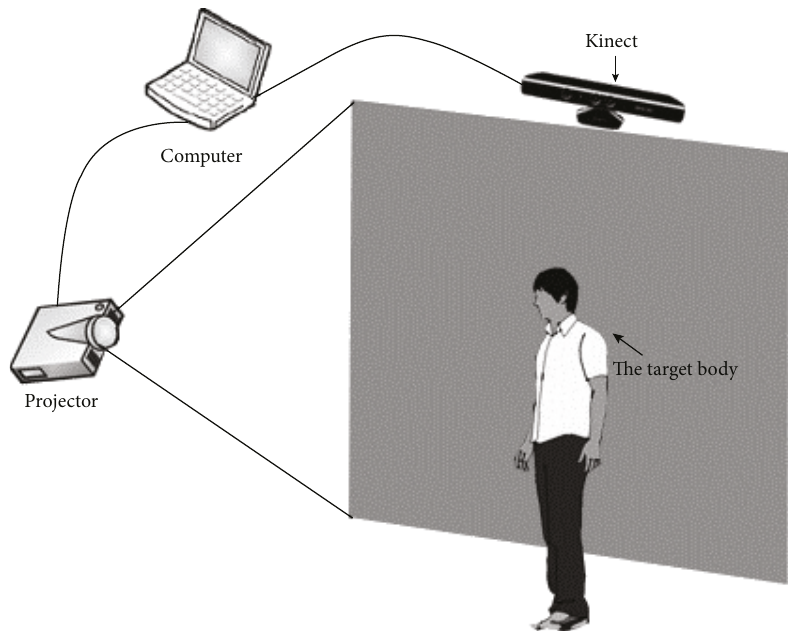
Figure 4: Schematic diagram of the interactive projection system based on Kinect depth